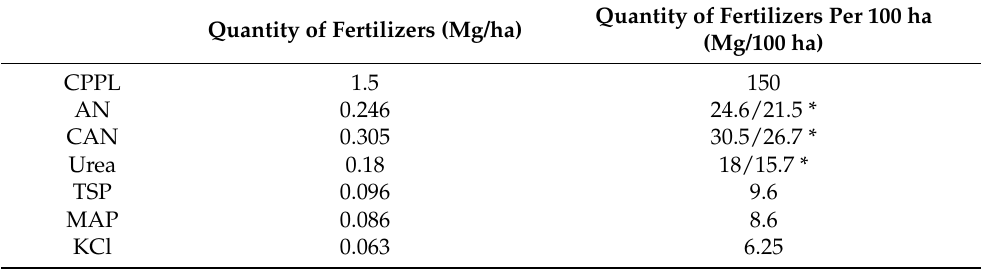
Table 5. NPK treatments of 100 ha of arable land based on the parameters of composted poultry granules.